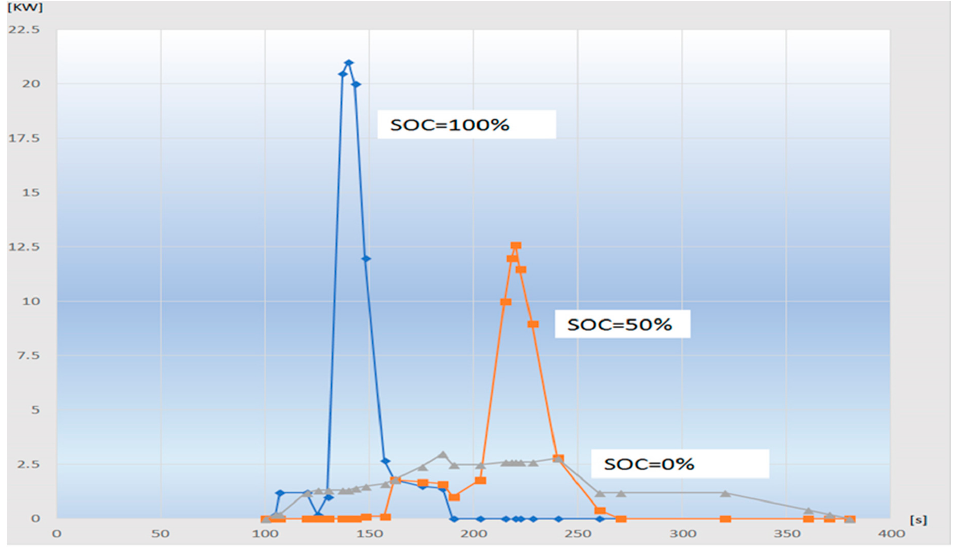
Figure 2. The heat release rate (HRR) as a function of time, depending on SOC (Own elaboration on the basis of the data from [18]).